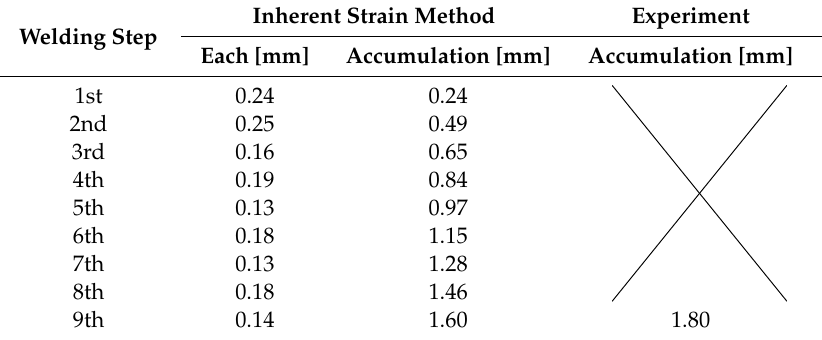
Table 5. Transverse shrinkage of aluminum battery housing model.